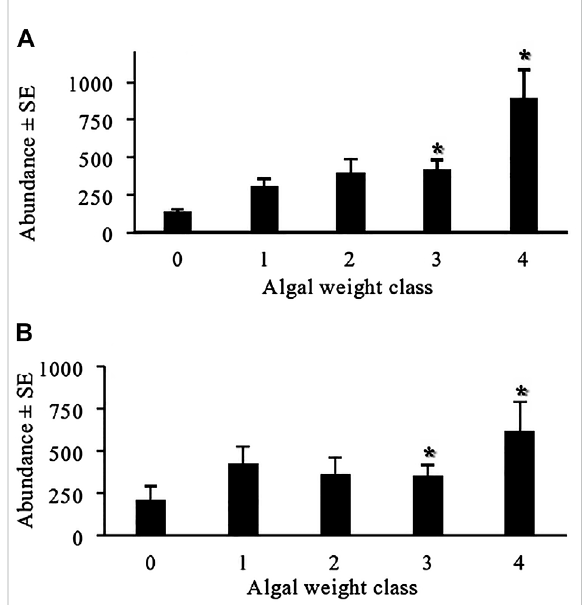
FIGURE 1 Average (+SE) small nekton abundance across drift macroalgae weight classes in the early summer benthic sled samples. Abundance measurements were collected from the epibenthic sledpull,whichcovereda10 m 2 area. The asterisk (*)indicatesthatthereisasigni fi cantdifferenceinthealgaeweight class compared to that when no algae were present. The full data set (A) and subset in which seagrass was held constant (B) showed a similar pattern of increased abundance at algal concentrations greaterthan 500 g.Inthisdata set, “ 0 ” indicates thatnoalgae were presentinthesledsample[ n =19,22(full,subset, respectively)], “ 1 ” indicates 1 – 300 g of algae ( n = 37, 30), “ 2 ” represents 301 – 500 g ofalgae( n =19,15), “ 3 ” represents501 – 1,000 gofalgae( n =19,9), and “ 4 ” represents samples containing over 1,001 g of algae ( n = 15,